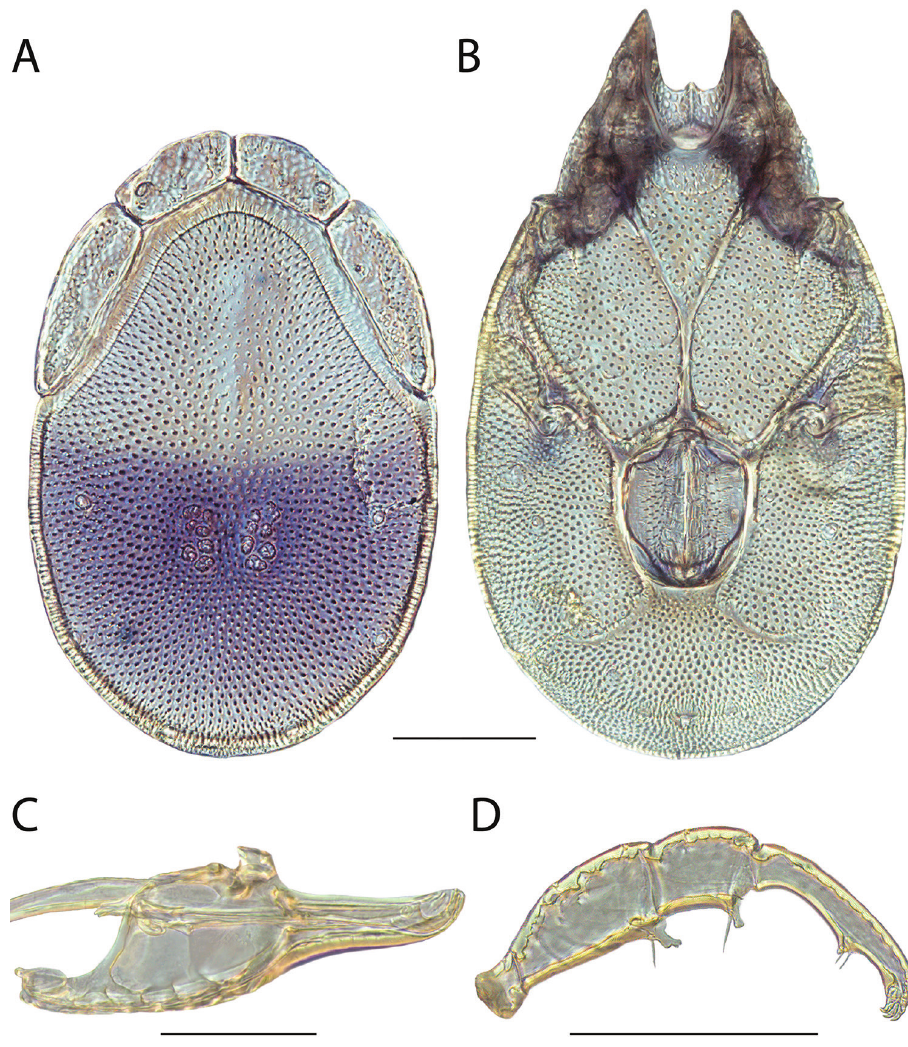
Figure 166. Torrenticola nigroalba male: A dorsal plates B venter (legs removed) C subcapitulum D pe- dipalp (setae not accurately depicted). Scale = 100 µm.